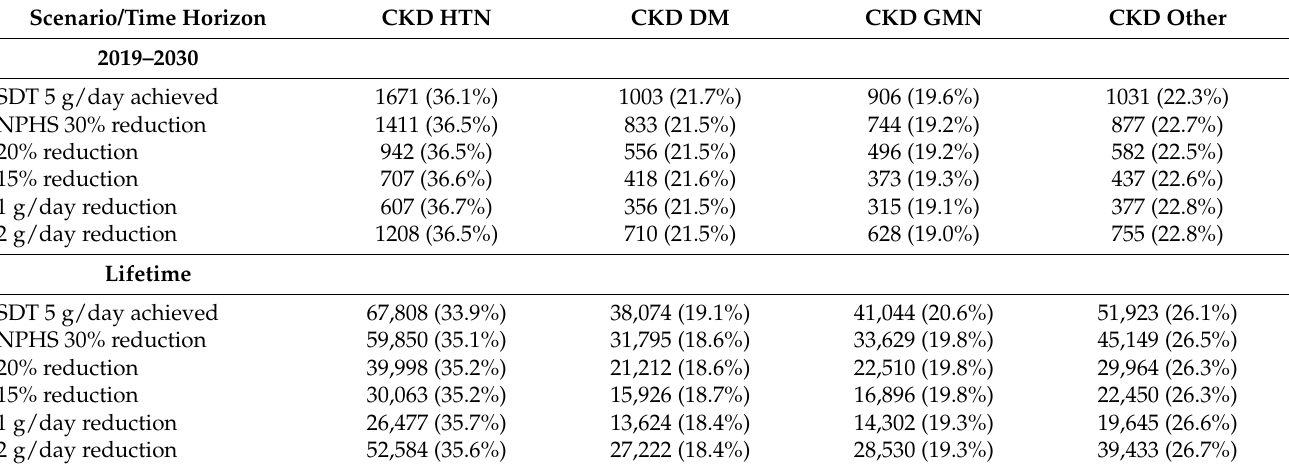
Table 4. Absolute and relative distribution of total HALY gains by CKD cause over different time